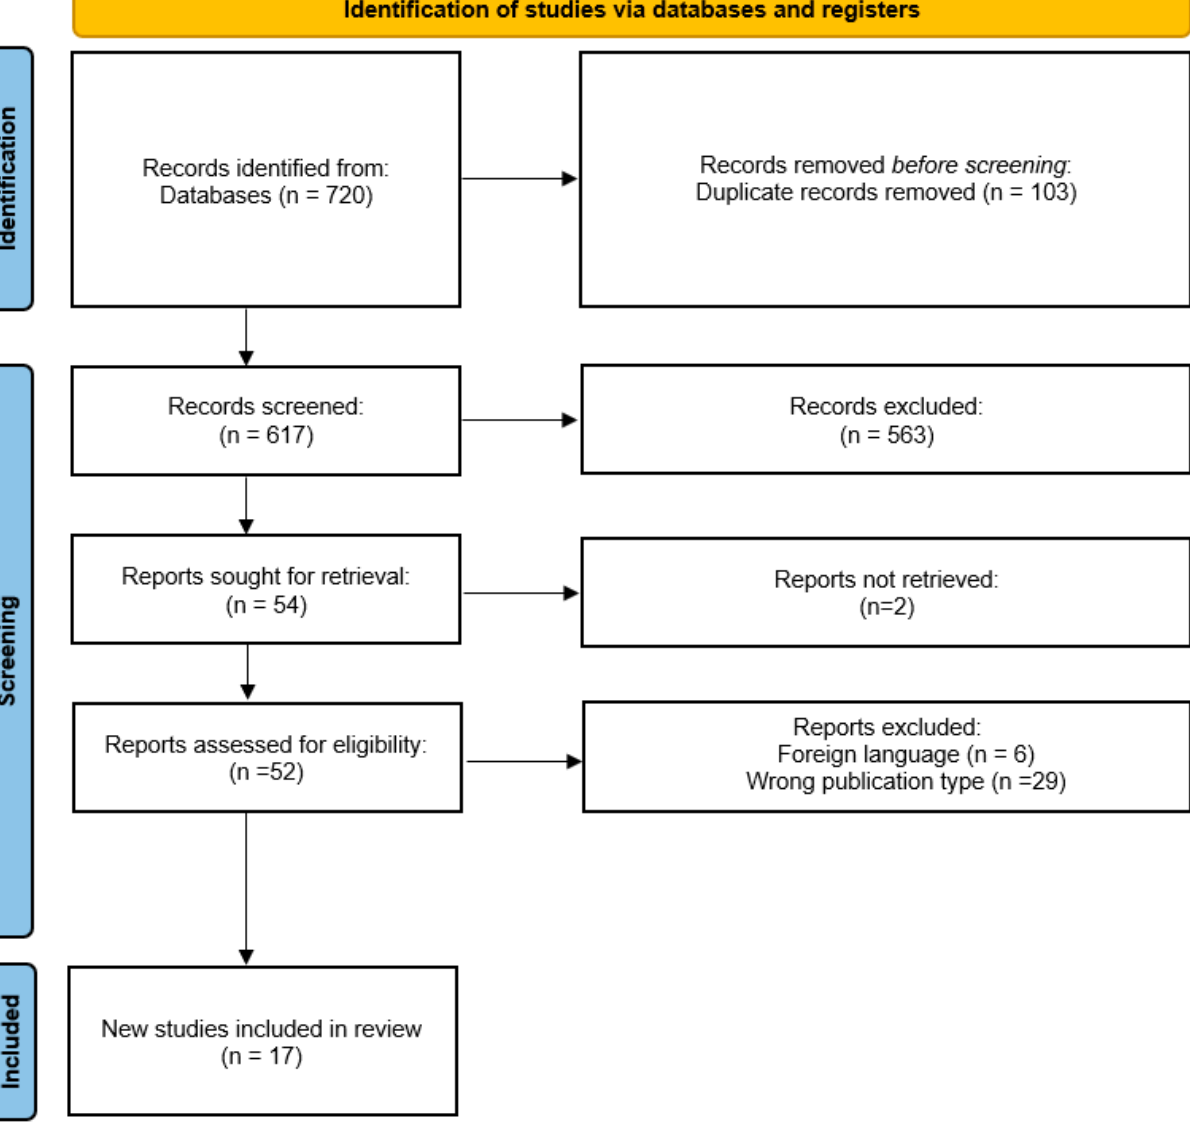
Figure 1. Flow diagram of the trial selection process. Extracted and adjusted from PRISMA [21].